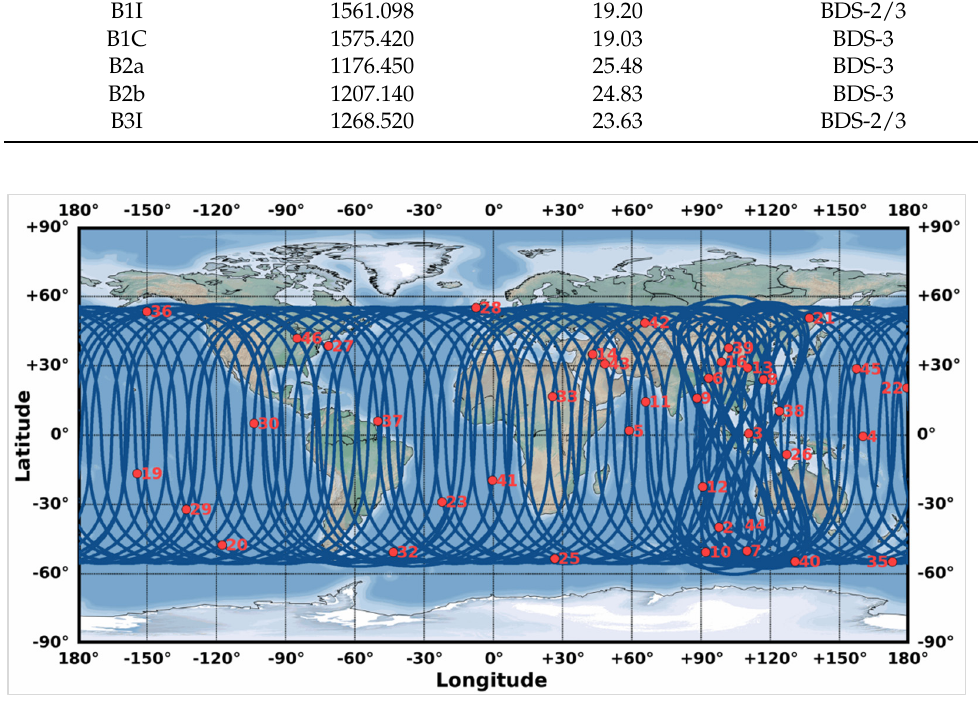
Figure 1. Footprints of BDS-2 and BDS-3 satellites (18 August 2021).